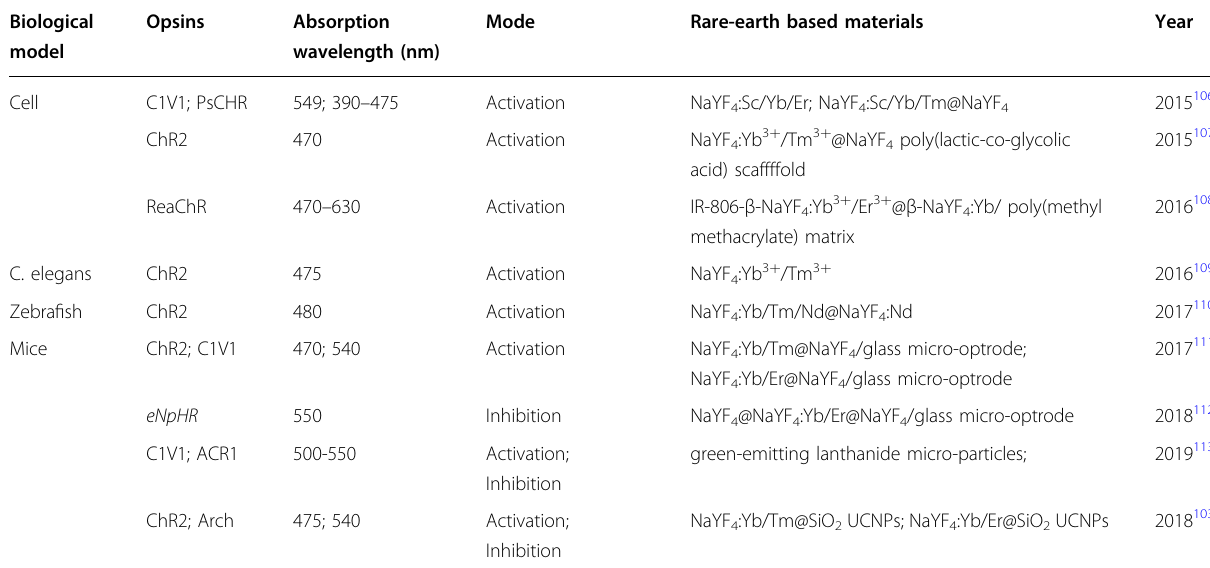
Table 2 The recent progress of rare-earth based materials-mediated optogenetics Biological